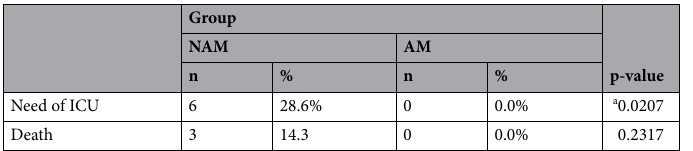
Table 3. Need of Intensive Care Unit (ICU) and deaths in NAM and AM groups. a Fisher’s exact test. NAM Non active mouthwash, AM Active